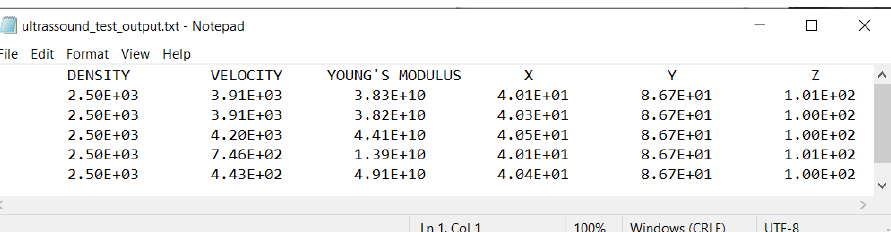
Figure 5. Surface electrical resistivity of a marble block.